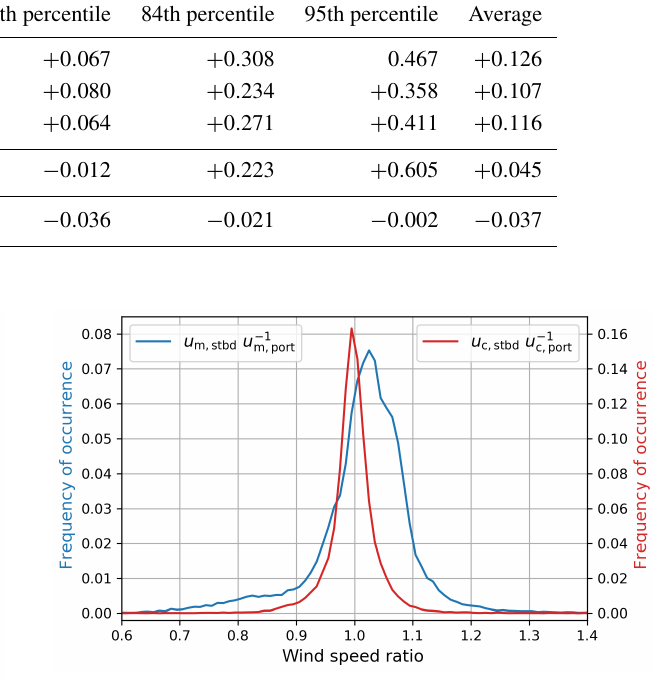
Figure 10. Histograms of the ratio of the true wind speed estimate from the starboard and port sensors with (red line) and without (blue Figure 9. Bi-dimensional histogram of the u m , stbd u − 1 ratio (the c , stbd line) the correction effect of the flow distortion correction on the true wind speed esti- mate) versus the relative wind direction D m , stbd . Counts are pro- vided in a 1 ◦ resolution in the wind direction and in a logarithmic resolution of d log 10 = 0 . 005 for the ratio. The yellow line shows the histogram of u m u − 1 c integrated over all wind directions (top x axis). The frequency of occurrence is provided over linear inter- vals of the wind speed ratio with a width of 0 . 02 and plotted on the logarithmic scale of the common y axis.